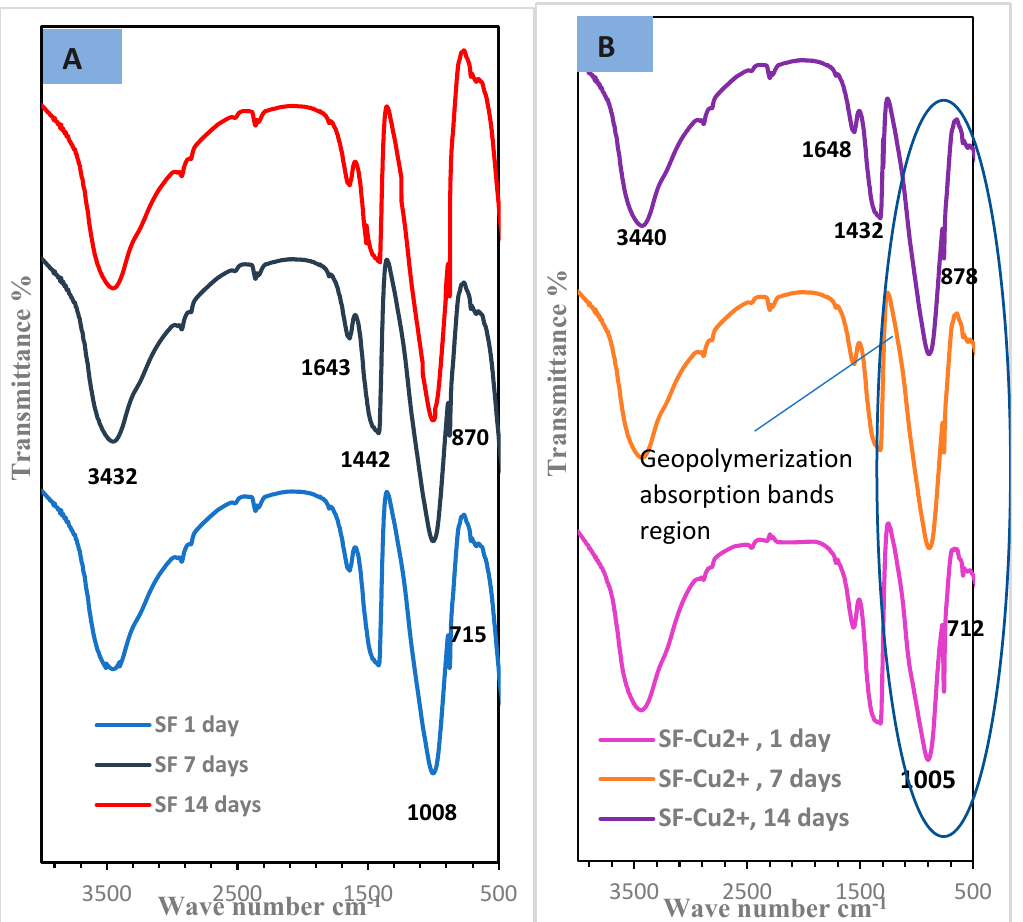
Figure 7. FTIR spectra of different geopolymer mixes cured in water for different hydration ages, ( A ) SF, ( B ) SF-RD-Cu 2+